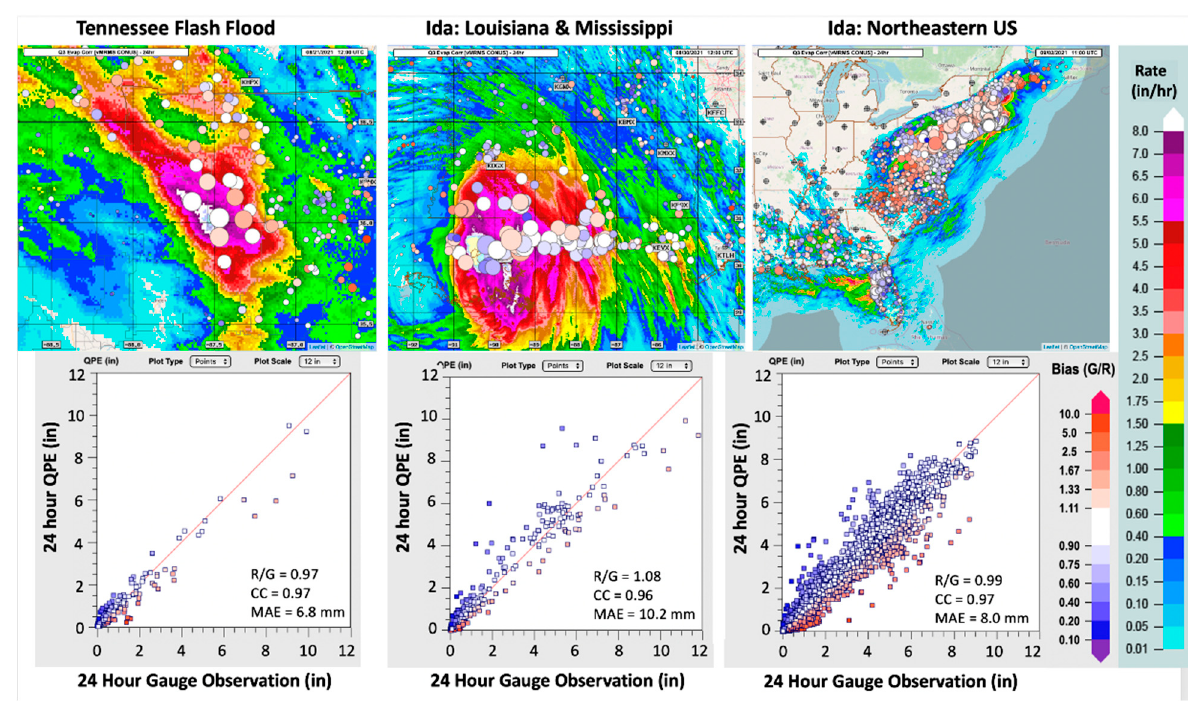
Figure 8. ( Top panels ): The maps of 24-h rain total estimated using Q3DP rainfall algorithm in Tennessee during the period ending at 1200 UTC on 21 August 2021, in Louisiana during the period ending at 1200 UTC on 30 August 2021, and US northeast during the period ending at 1100 UTC on 2 September 2021. Colored dots represent CoCoRaHS gauge sites. The size of the dots represents gauge observed amounts and the color represents the gauge/QPE (G/R) bias ratios. ( Bottom panels ): Scatterplots of radar 24-h rain totals versus their gauge estimates. The statistic scores in the scatterplots are the bias ratio (R/G), mean absolute error (MAE), and correlation coefficient (CC).